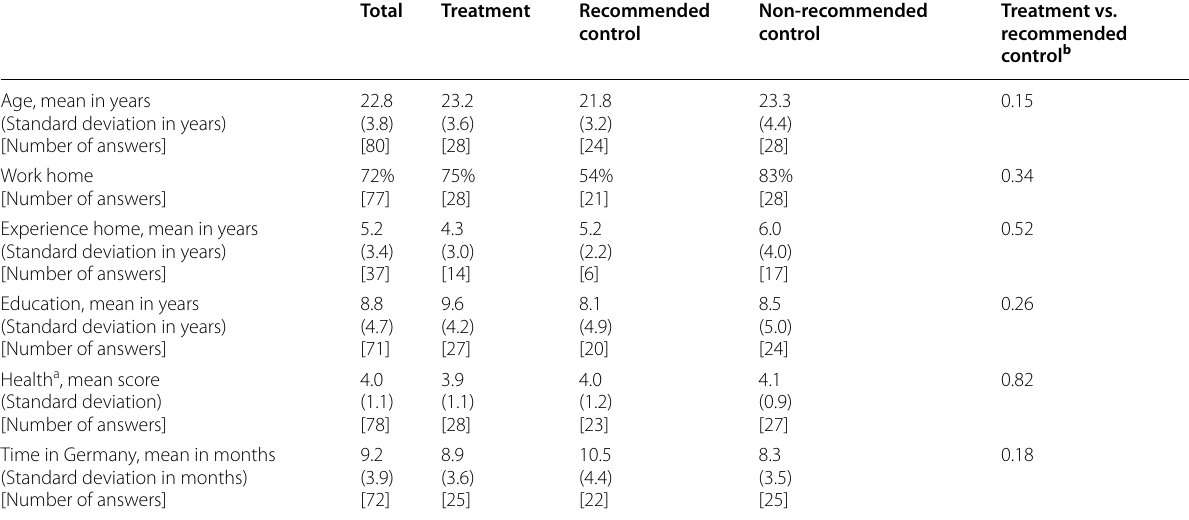
Table 4 Characteristics of